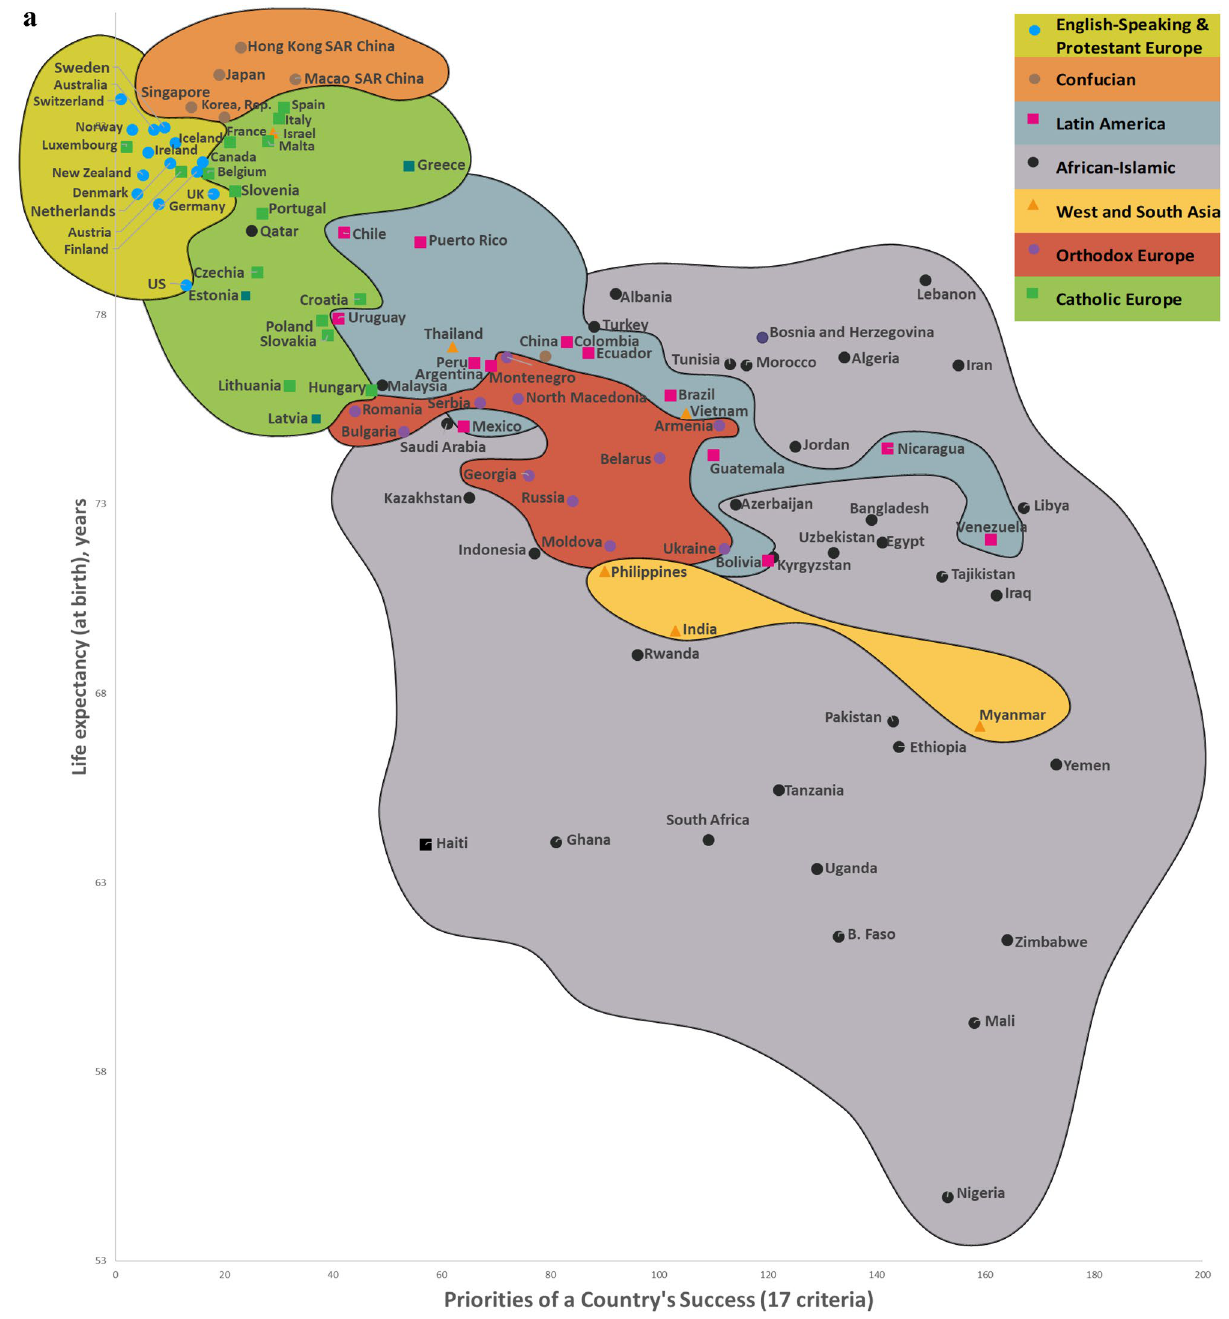
Figure 3. Country success and social sustainability world maps: ( a ) CSS life expectancy at birth map. ( b ) CSS happiness index map. ( c ) CSS positive peace index